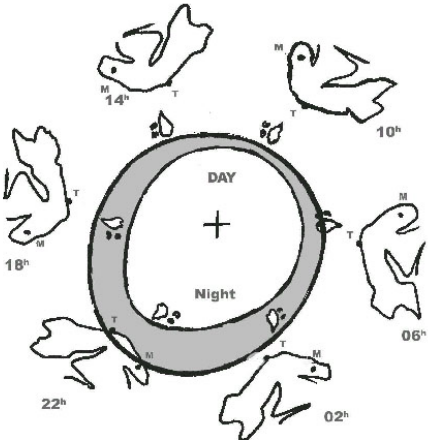
Fig. 21. The auroral oval and the position of Spitsbergen at differ- ent times of the day during a year of solar activity